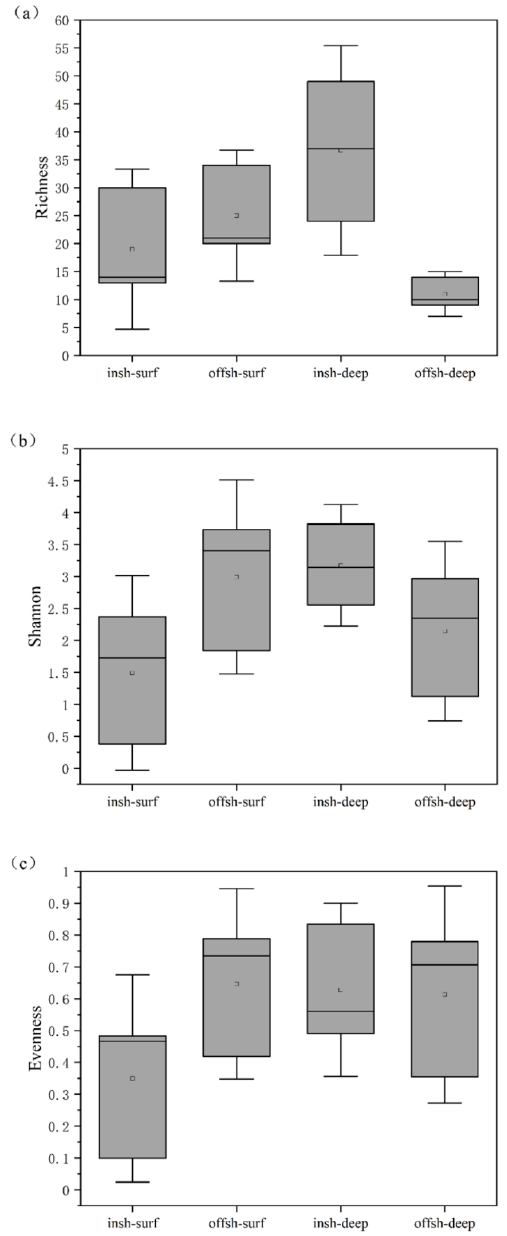
Figure 3. Richness ( a ); Shannon diversity ( b ); and evenness ( c ) for the Labyrinthulomycetes com- munities from different habitats. Labels “insh-surf”, “offsh-surf”, “insh-deep” and “offsh-deep” represent inshore surface water, offshore surface water, inshore deep water, and offshore deep water, respectively. The boxes represent the ranges of the first and third quartiles, the line and small square inside each box represent the median and mean values, and the ends of the whiskers represent the minimum and maximum values.